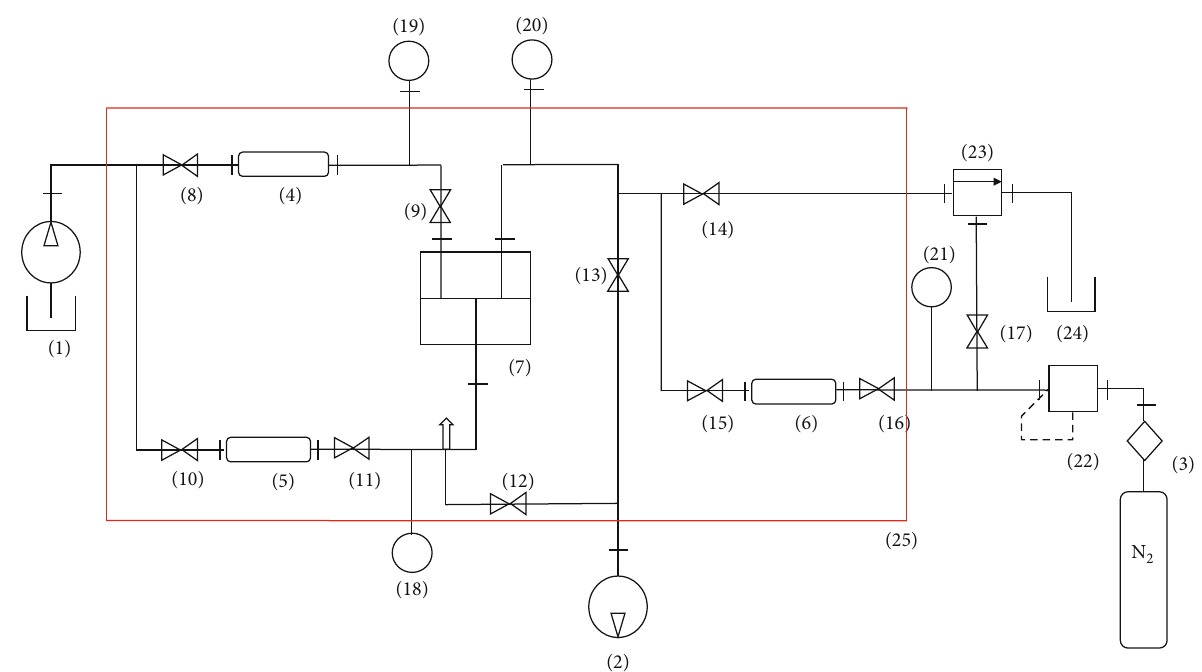
Figure 3: Flow chart of the pressure transmission test: (1) ISCO pump, (2) vacuum pump, (3) nitrogen gas bottle, (4) intermediate vessel for upstream and (5) downstream formation fl uids, (6) intermediate container for testing fl uids, (7) special core gripper, (8 – 17) control valve,